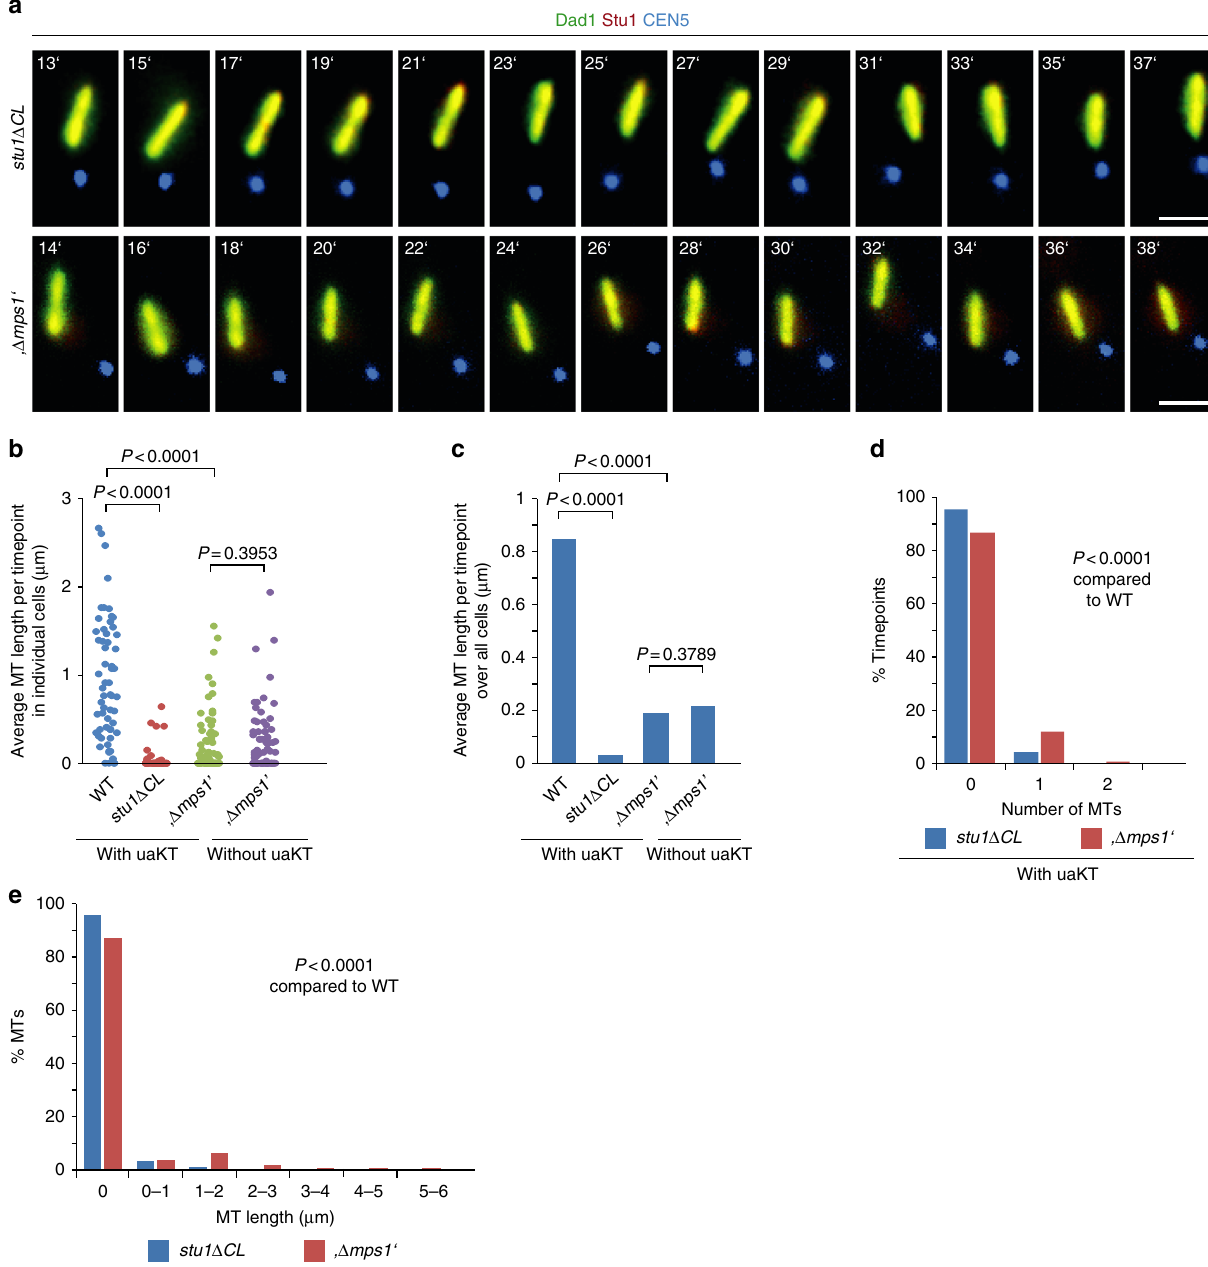
Fig. 4 The enhanced formation of nrMTs fails if the sequestering of Stu1 at an uaKT is defective and the spindle remains uncompromised. a – e The experiment with stu1 Δ CL and Mps1-depleted cells (genotypes see Supplementary Table 1) was performed as described in Fig. 2 and visualized as in Fig. 3b. b – e The number and length of nrMTs were determined. Cells with an uaKT were observed for 15 timepoints or until the uaKT was captured. The data corresponding to WT cells with an uaKT, as shown in Fig. 3d and e, has been included for comparison. Statistics, see Supplementary Table